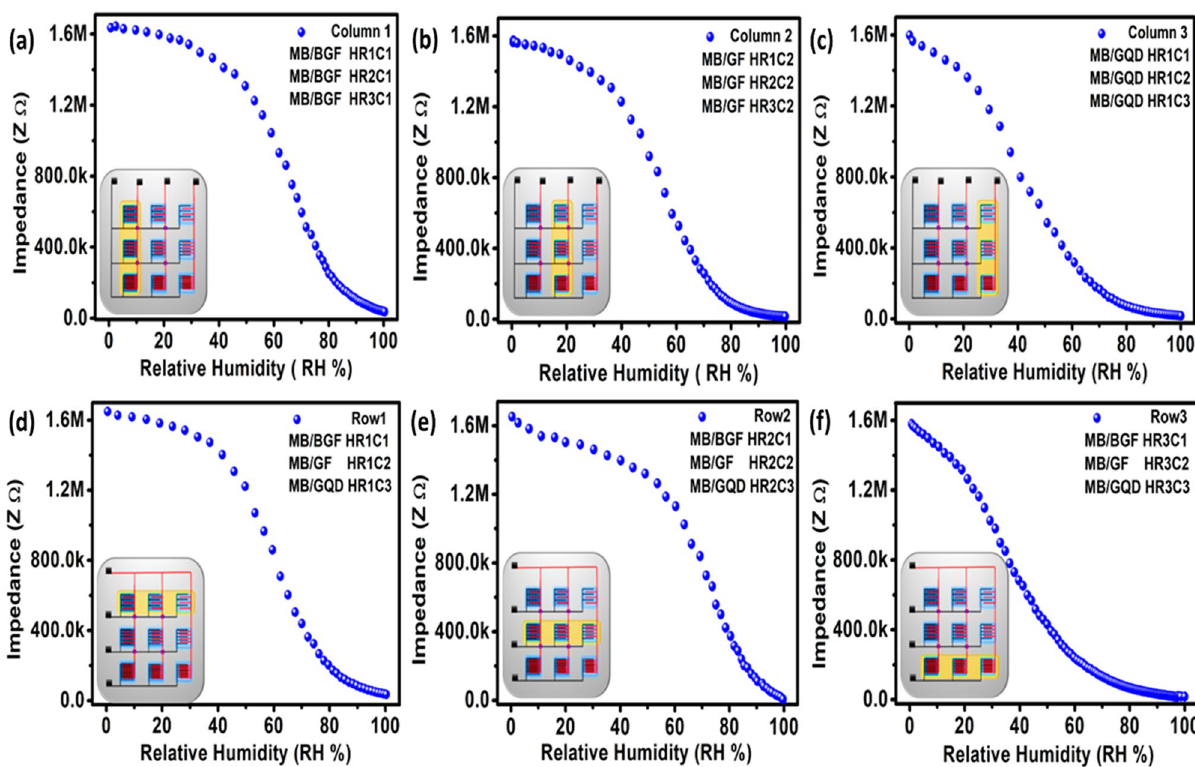
Figure 5. Impedance response of parallel combination of ( a ) column 1, ( b ) column 2 and ( c ) column 3, ( d ) row 1, ( e ) row 2, and ( f ) row